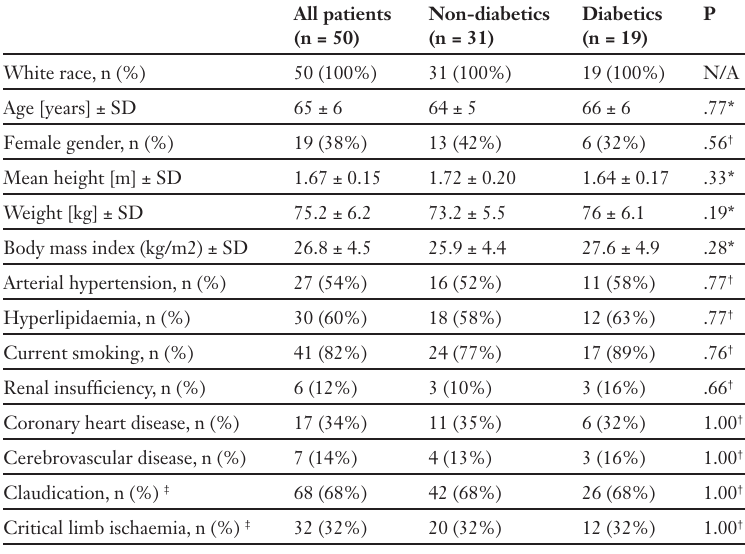
Characterisation of the investigated patient